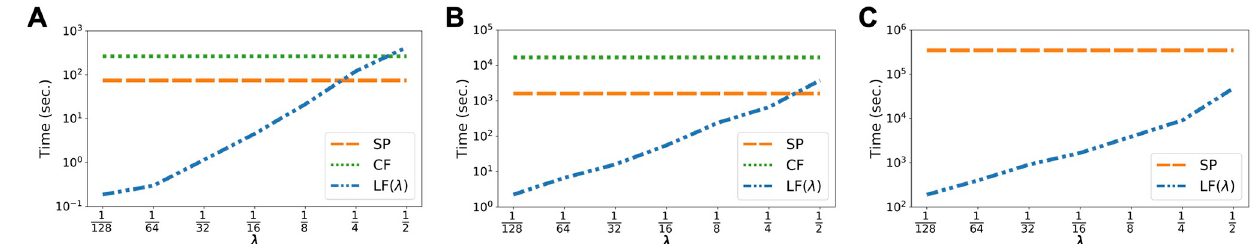
Fig 12. Computation time of betweenness measures. All computations are carried out on a personal laptop with 32GB RAM and 2.9 GHz 6-Core Intel Core i9. We used NetworkX [55] for computing SP and CF. We implemented LF computation in Julia. Note that the computation time scales linearly with λ . Moreover, since the range of λ values shown in the figures includes the values we used for our experiments, one may obtain accurate estimates on the computation times of all betweenness measures we used for the experiments. (A) Computation times for Facebook County. (B) Computation times for Port. Sub. (C) Computation times for Wi-Fi Montreal. CF is omitted for Wi-Fi Montreal because it takes too long to